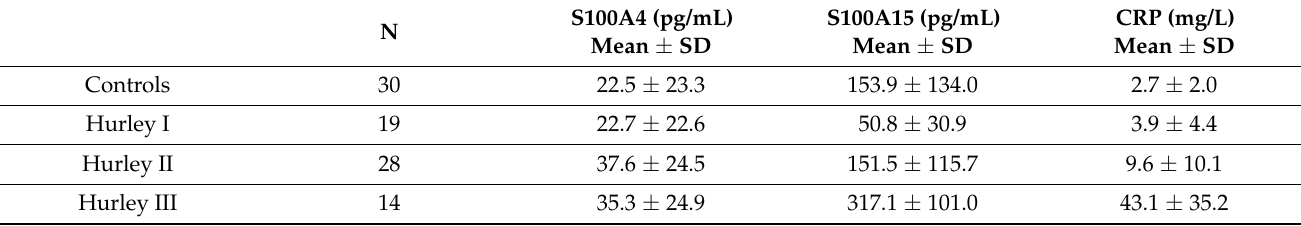
Table 2. Serum levels of S100A4, S100A15 and C-reactive protein (CRP) in healthy controls and patients with hidradenitis suppurativa, according to Hurley staging system.